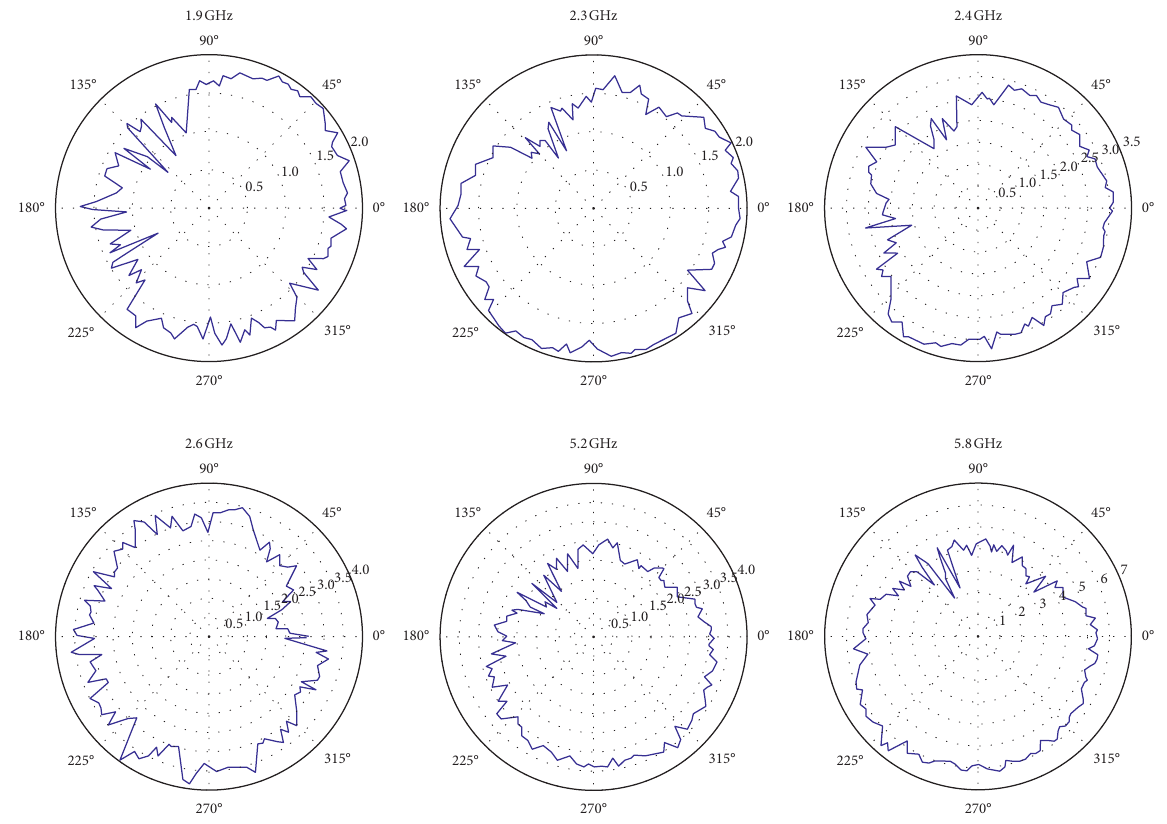
Figure 8: Elevation view of the radiation